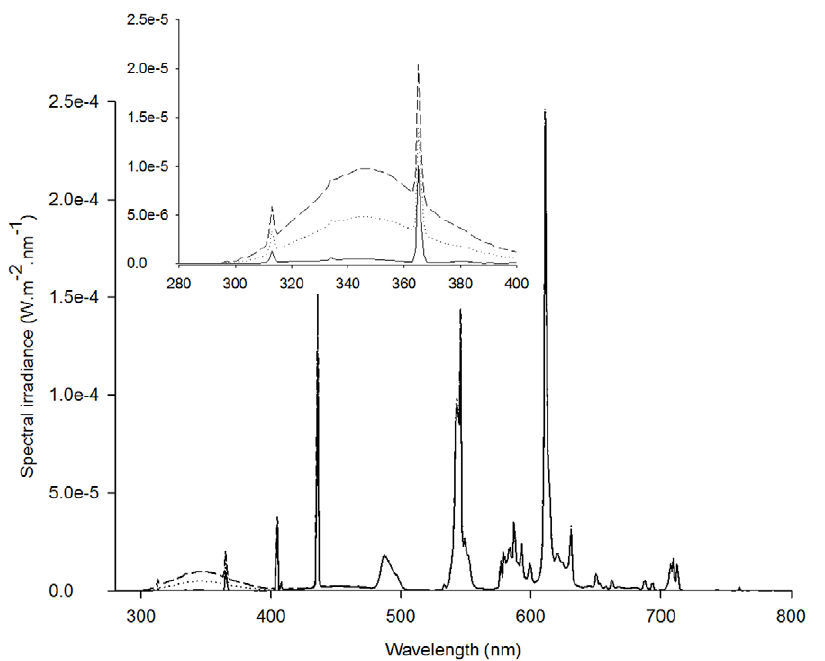
Figure 1. Spectral irradiance for the 3 treatments: PAR (solid line), PAR plus ambient UVR (dotted line), and PAR plus enhanced UVR (dashed line) measured inside the Teflon bags that were used for culturing the algae.